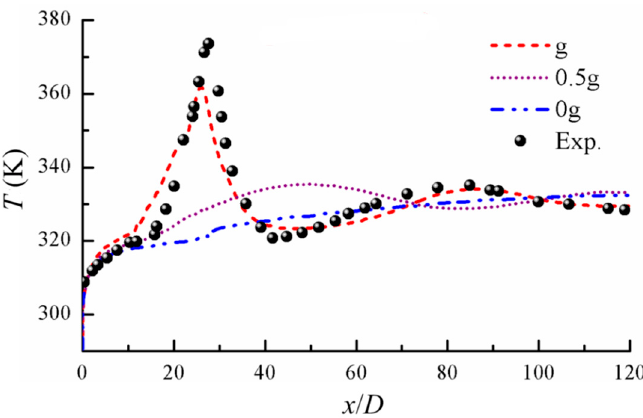
Figure 23. Distribution of the tube wall temperature ( q = 56.7 kW/m 2 ).